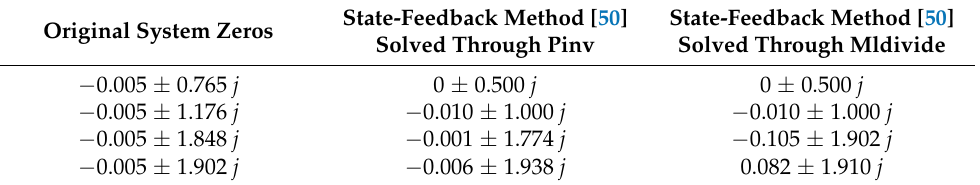
Table 8. Zeros of the original and modified receptance h 3,4 (j ω ) with the different controllers to assign two complex conjugate zero